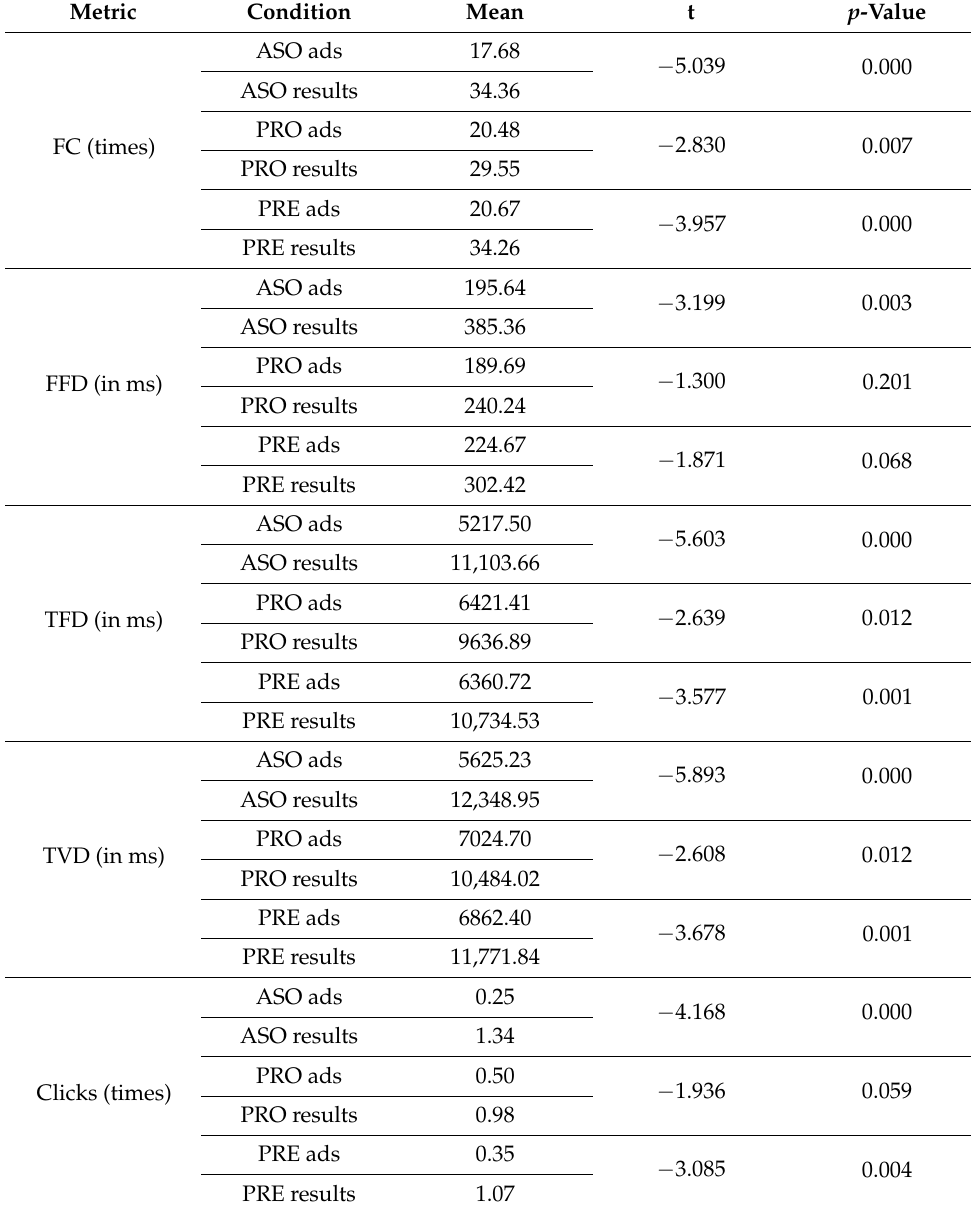
Table 2. Eye-tracking metrics and clicks for ad type vs. result type.